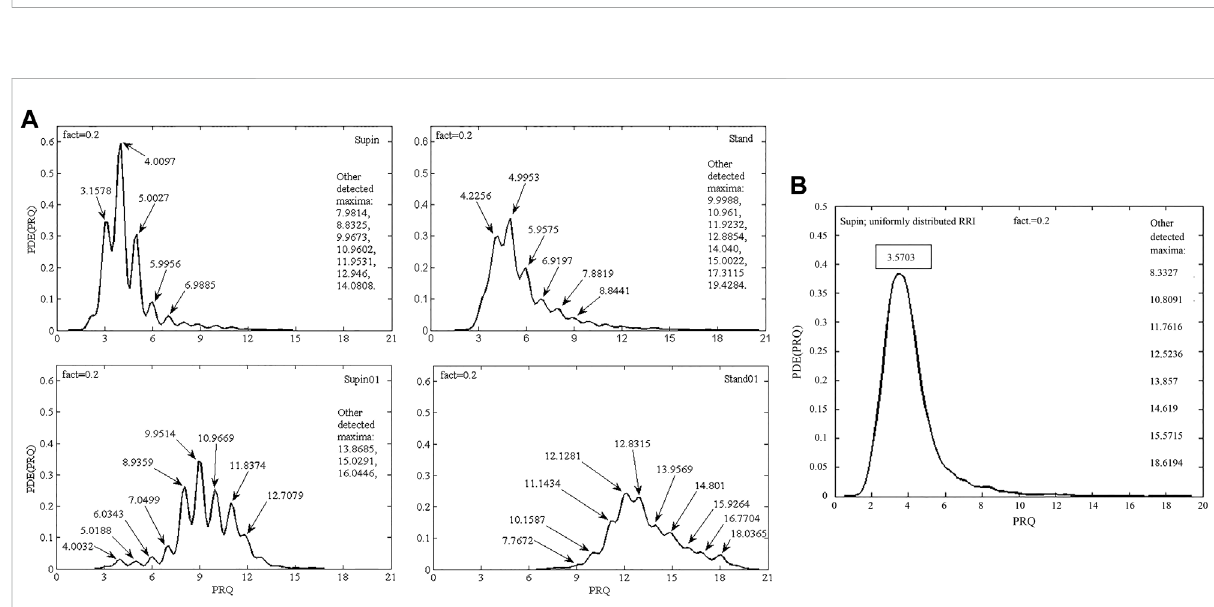
FIGURE 4 (A) PDE distribution pro fi les of the PRQ parameter for 20 subjects in four physiological states: Supin — supine position with spontaneous breathing, Stand — standing with spontaneous breathing, Supin01 — supine position with slow (0.1 Hz) breathing, Stand01 — standing with slow (0.1 Hz) breathing; fact — fi neness factor. Quantization around integer PRQ values is visible in most local maxima; (B) PDE distribution of PRQ parameter for 20 subjects that was calculated from arti fi cial RR intervals (RRI) with uniform distribution (random values within the physiological limits of the RRI parameter) and real BB